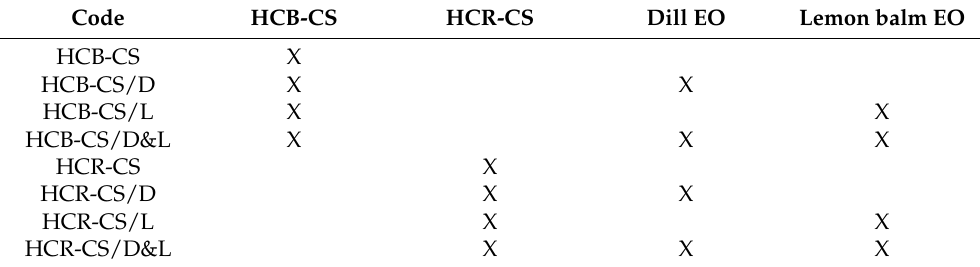
Table 2. Label and composition of nanofibers containing collagen, chitosan, and encapsulated essential oils prepared by electrospinning technique. HCB-CS is control nanofibers based on collagen hydrolysate from bovine tendons mixed with chitosan solution; HCB-CS/D is dill EO encapsulated into electrospun collagen hydrolysate from bovine tendons mixed with chitosan solution; HCB- CS/L is lemon balm EO encapsulated into electrospun collagen hydrolysate from bovine tendons mixed with chitosan solution; HCB-CS/D&L is a mixture of dill and lemon balm EOs encapsulated into electrospun collagen hydrolysate from bovine tendons mixed with chitosan solution; HCR- CS is control nanofibers based on collagen hydrolysate from rabbit skins mixed with chitosan solution; HCR-CS/D is dill EO encapsulated into electrospun collagen hydrolysate from rabbit skins mixed with chitosan solution; HCR-CS/L is lemon balm EO encapsulated into electrospun collagen hydrolysate from rabbit skins mixed with chitosan solution; HCR-CS/D&L is a mixture of dill and lemon balm EOs encapsulated into electrospun collagen hydrolysate from rabbit skins mixed with chitosan